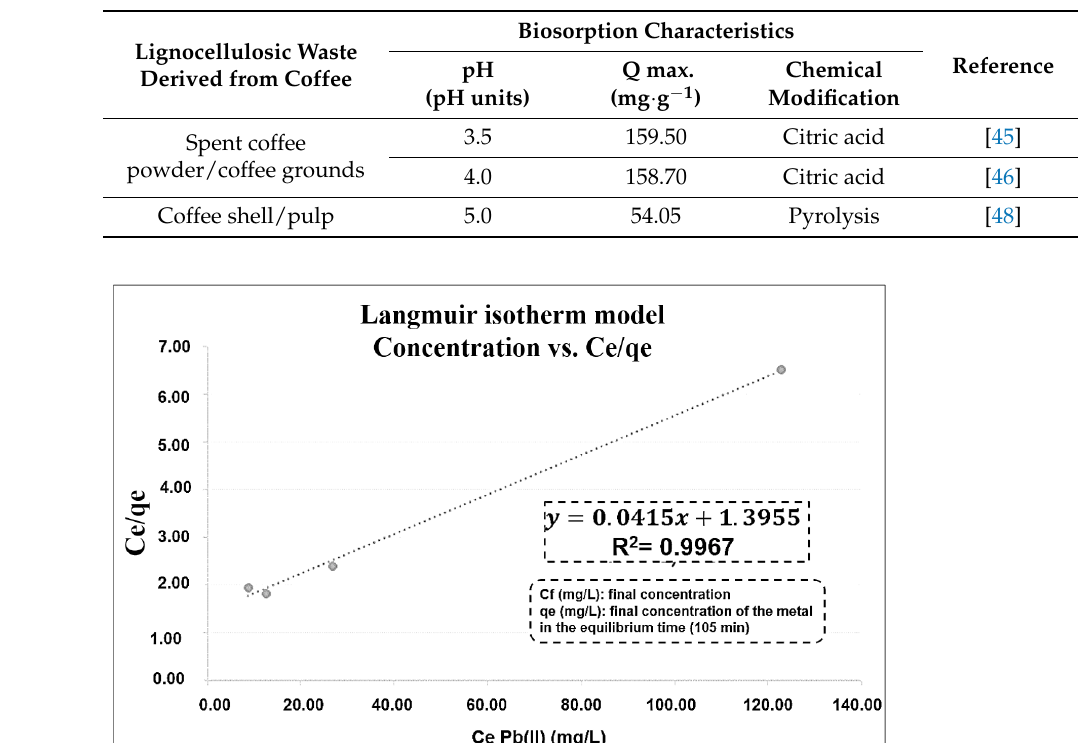
Table 5. Capacity of maximum adsorption of coffee wastes with chemical modification.